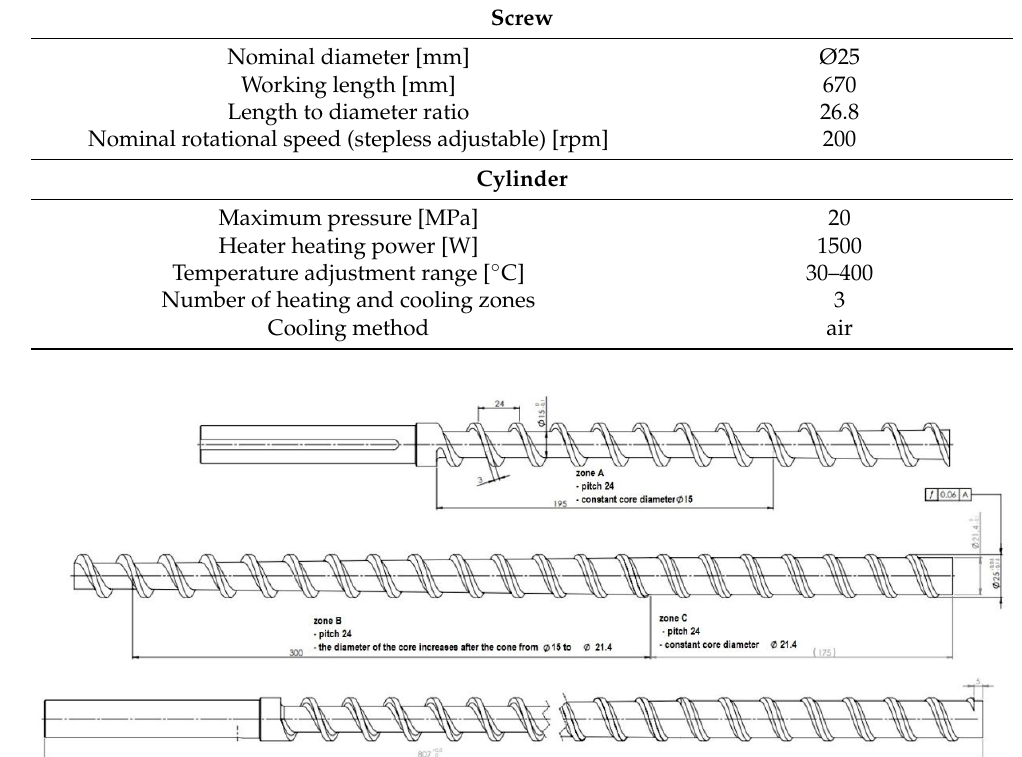
Figure 4. Geometry of a single-screw Ø25 extruder (Source: [29]).